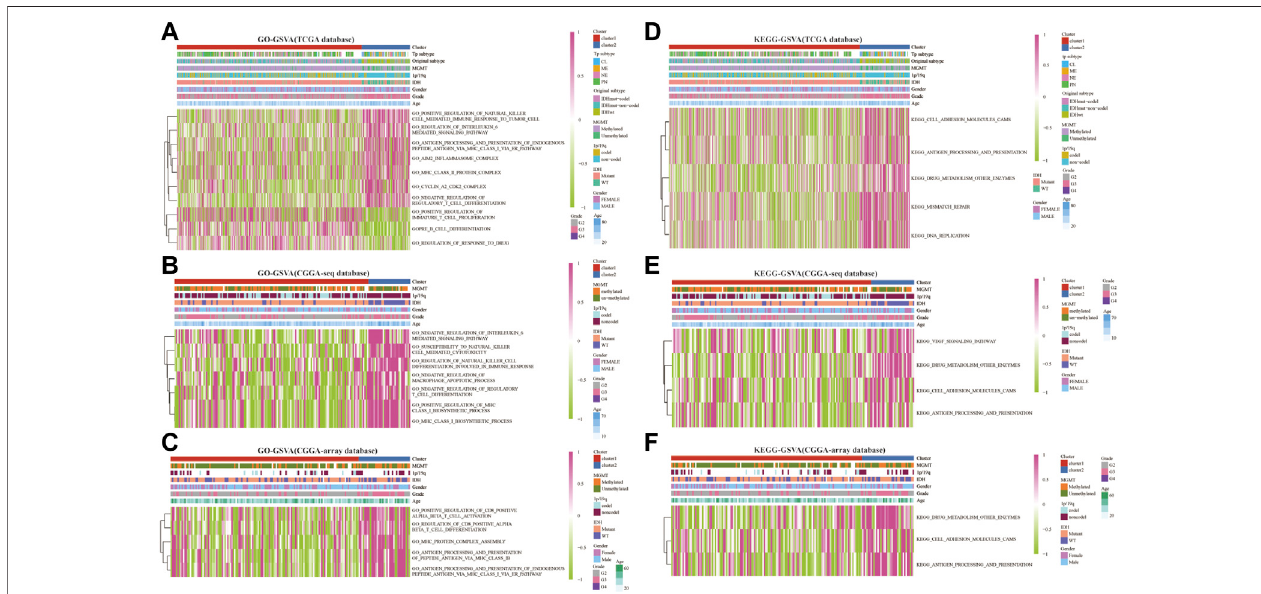
FIGURE 3 | RNF proteins-related biological functions in cluster 1 and cluster 2 from the training and validation cohorts. Gene set variation analysis in cluster 1 and cluster 2 based on GO database from the TCGA (A) , CGGA-sequence (B) , and CGGA-array (C) databases. Gene set variation analysis in cluster 1 and cluster 2 based on the KEGG database from the TCGA (D) , CGGA-sequence (E) , and CGGA-array (F) databases.